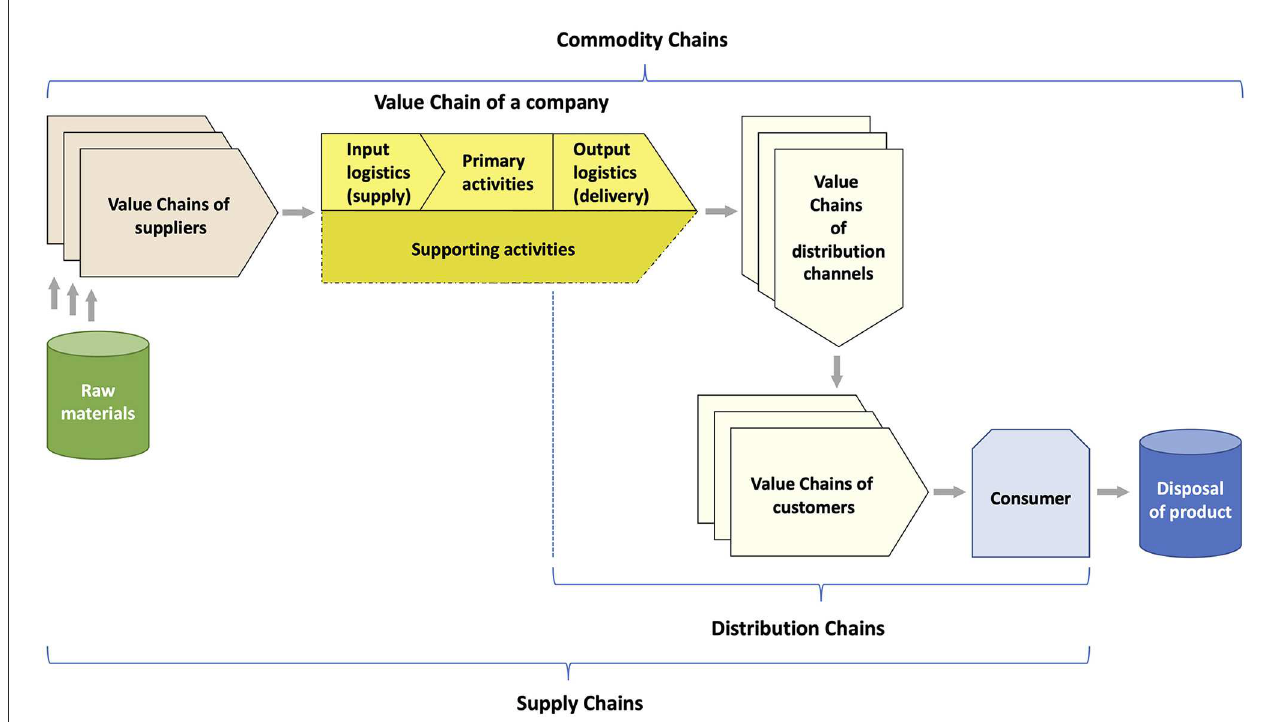
FIGURE2 Ranges of and relations between commodity chains, supply chains, distribution chains, and value chains.